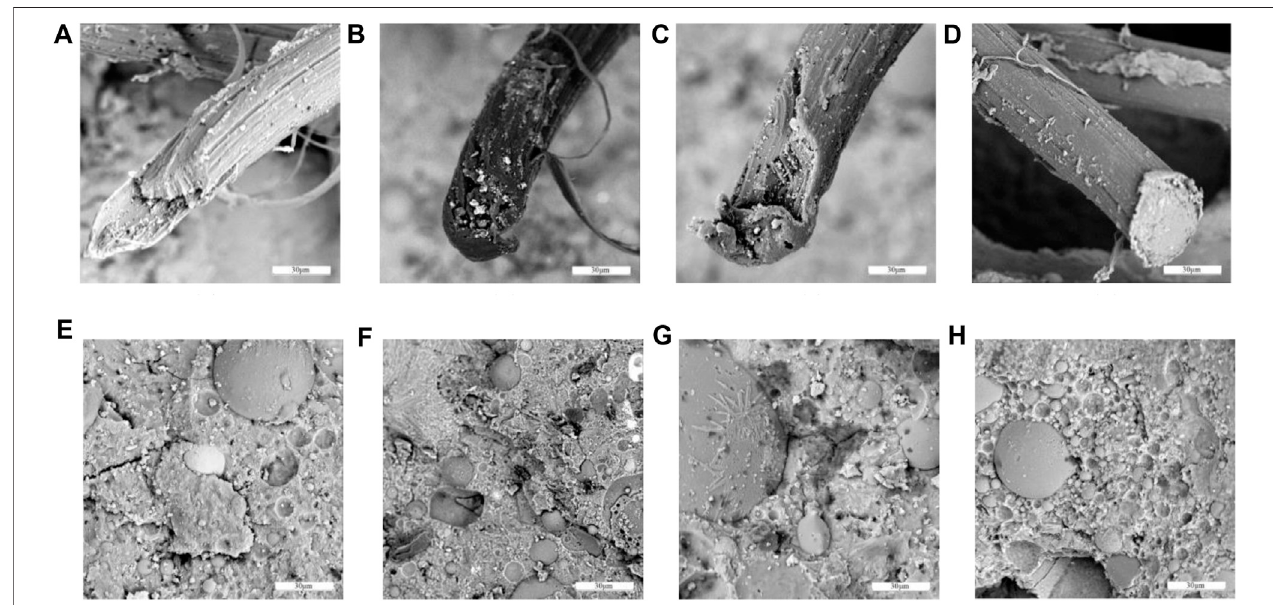
FIGURE 6 | SEM images of the microstructure on the fracture surface of ECCs: (A) and (E) represent A1B3C3, (B) and (F) represent A2B2C3, (C) and (G) represent A3B2C1, and (D) and (H) represent M45.